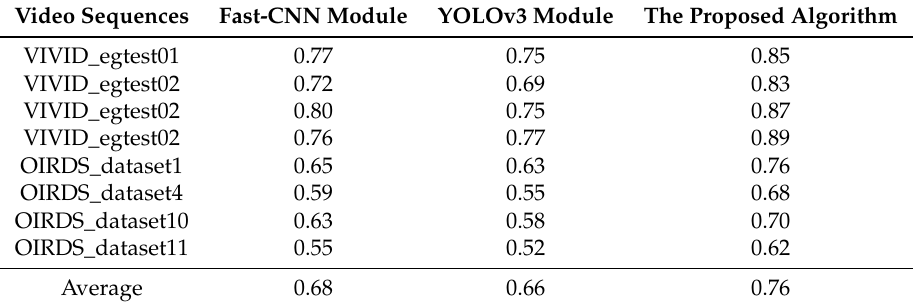
Table 3. IoU of the Fast-CNN module, YOLOv3 module, and improved YOLOv3 framework (s).